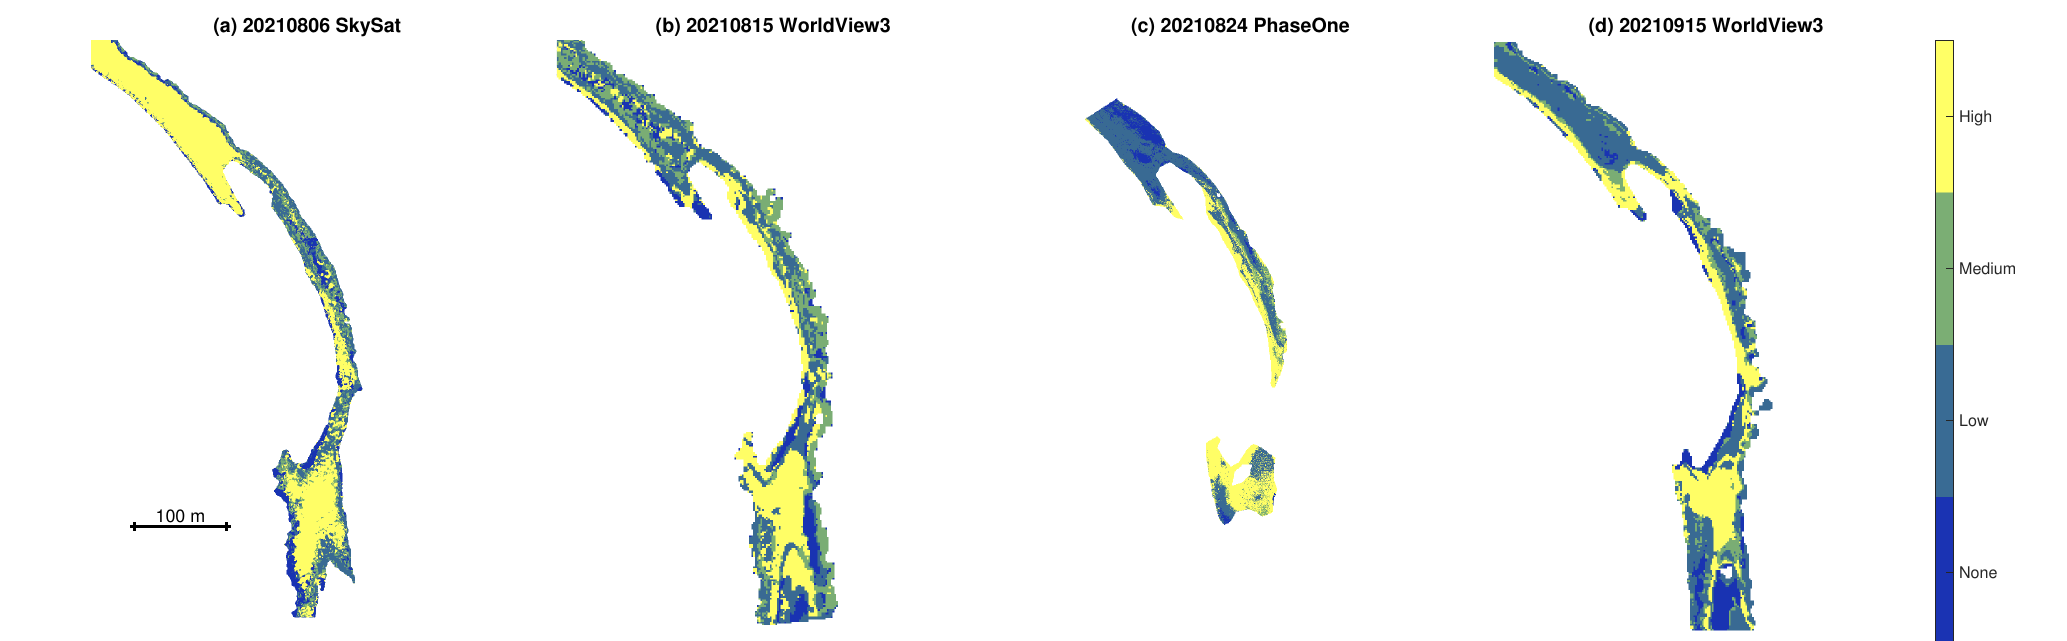
Figure 11. Time series of algal density classification maps produced from various images of the Maumee reach of the Buffalo River. ( a ) SkySat image from 6 August 2021; ( b ) WorldView3 image from 15 August 2021; ( c ) PhaseOne image from 24 August 2021; ( d ) WorldView3 image from 15 September